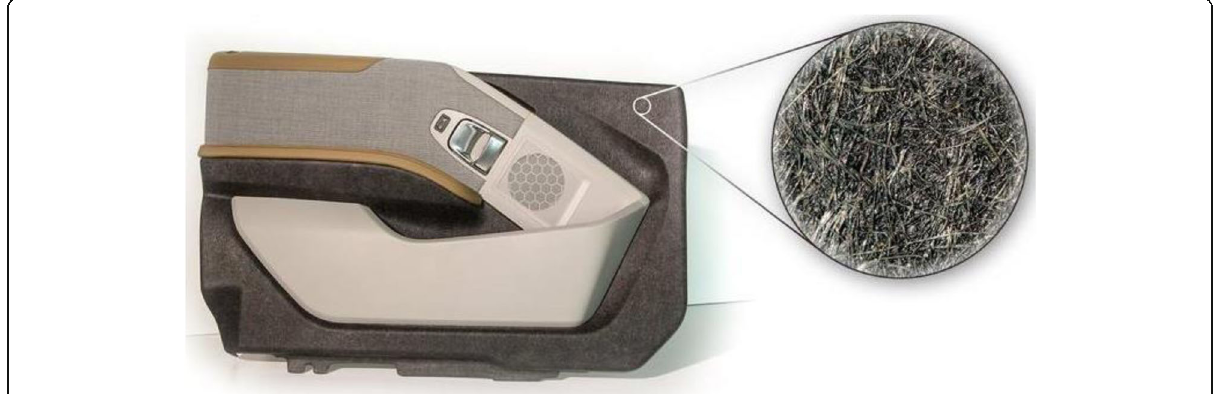
Fig. 4 Untreated door panel with natural materials. Source: Dräxlmaier,